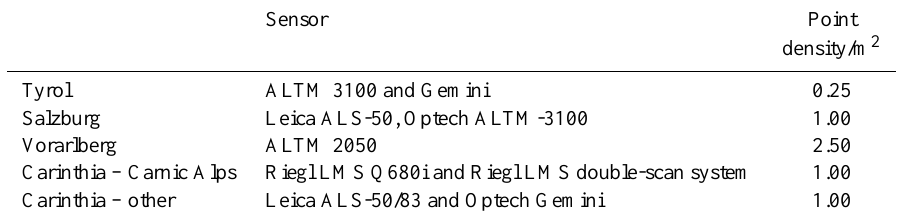
Table 1. Sensor and point densities.